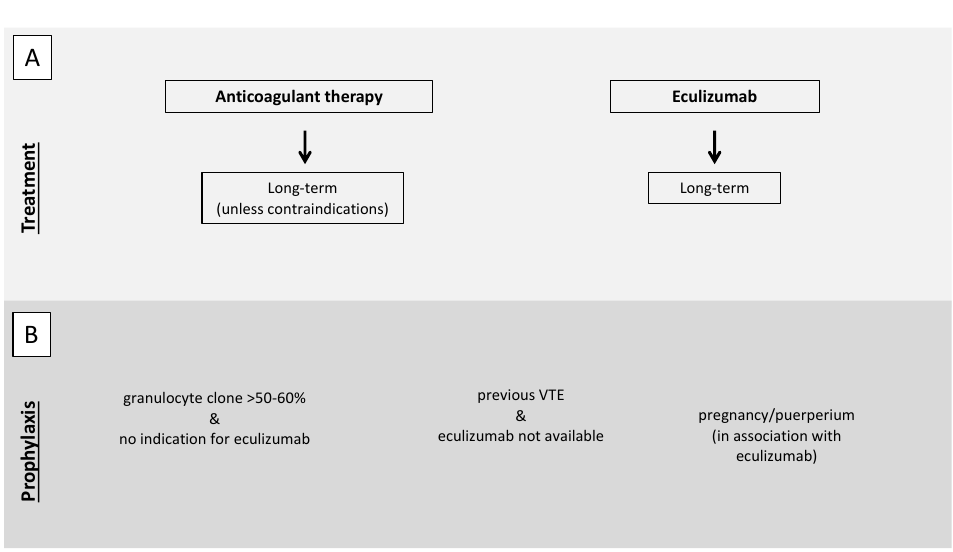
Figure 3. Proposed recommendations for treatment ( A ) and prophylaxis ( B ) of VTE in PNH patients. ( A ). In the case of VTE, both anticoagulant therapy and eculizumab should be immediately started. Anticoagulant therapy should be continued long-term, independently of concomitant therapy with eculizumab, unless contraindications are present such as bleeding or severe thrombocytopenia. ( B ) Antithrombotic prophylaxis should be considered in patients with a granulocyte clone >50–60% not fulfilling indication for eculizumab therapy, in patients with previous VTE in geographical areas in which eculizumab is not available, and during pregnancy and puerperium. VTE, venous thromboembolism; PNH paroxysmal nocturnal hemoglobinuria.